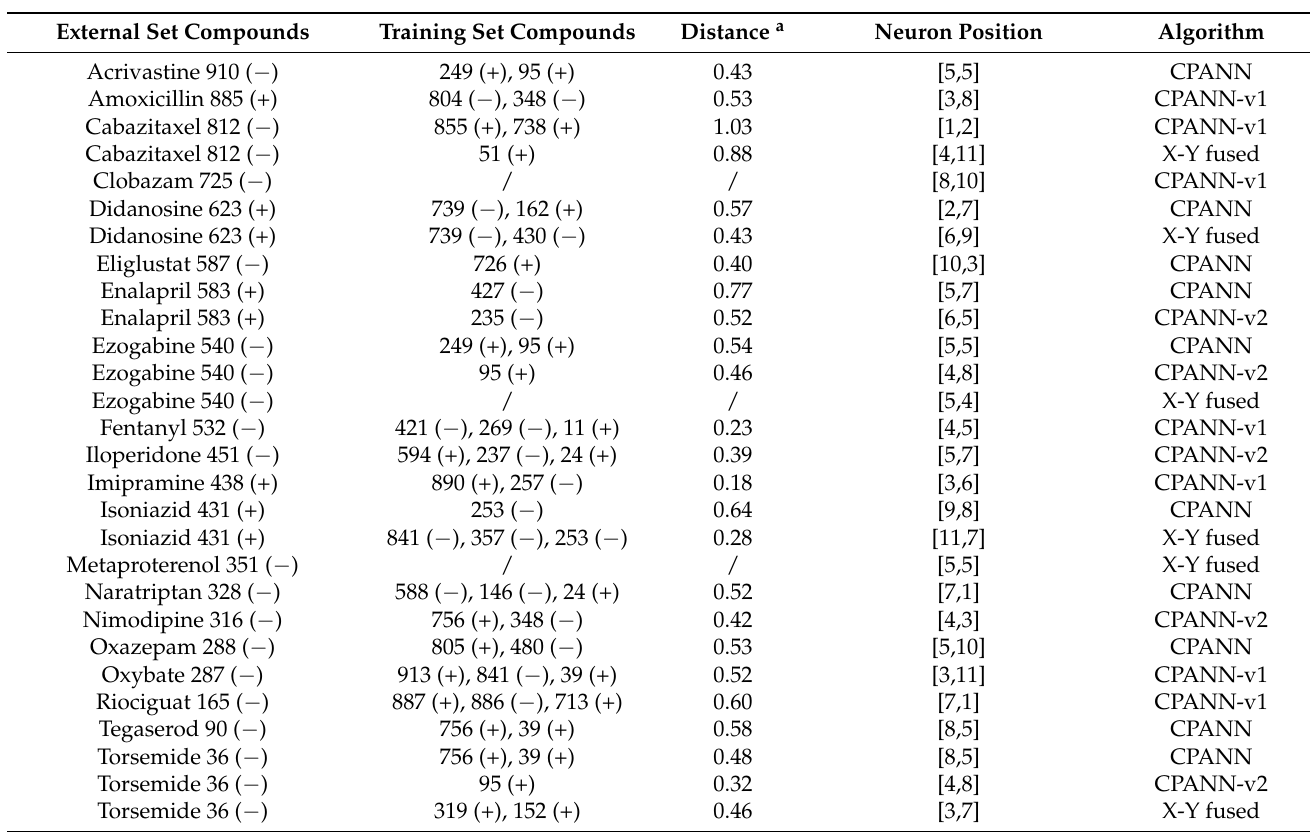
Table 4. Misclassified external set compounds.